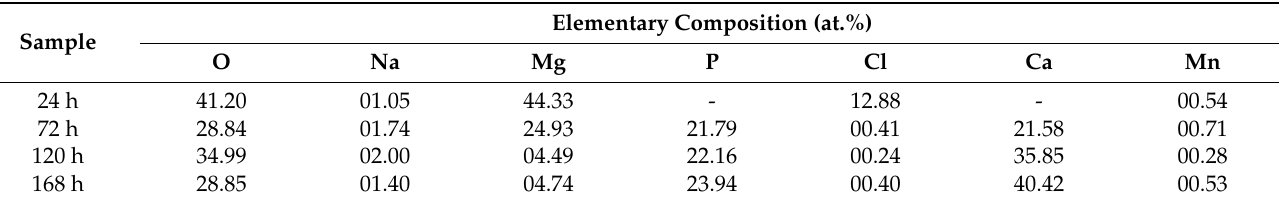
Figure 7. Microcorrosion morphologies of 12 h sample immersed in SBF solution: ( a1 , a2 ) 24 h, ( b1 , b2 ) 72 h, ( c1 , c2 ) 120 h, ( d1 , d2 ) 168 h. Table 3. EDS results on 12 h sample immersed in SBF solution.